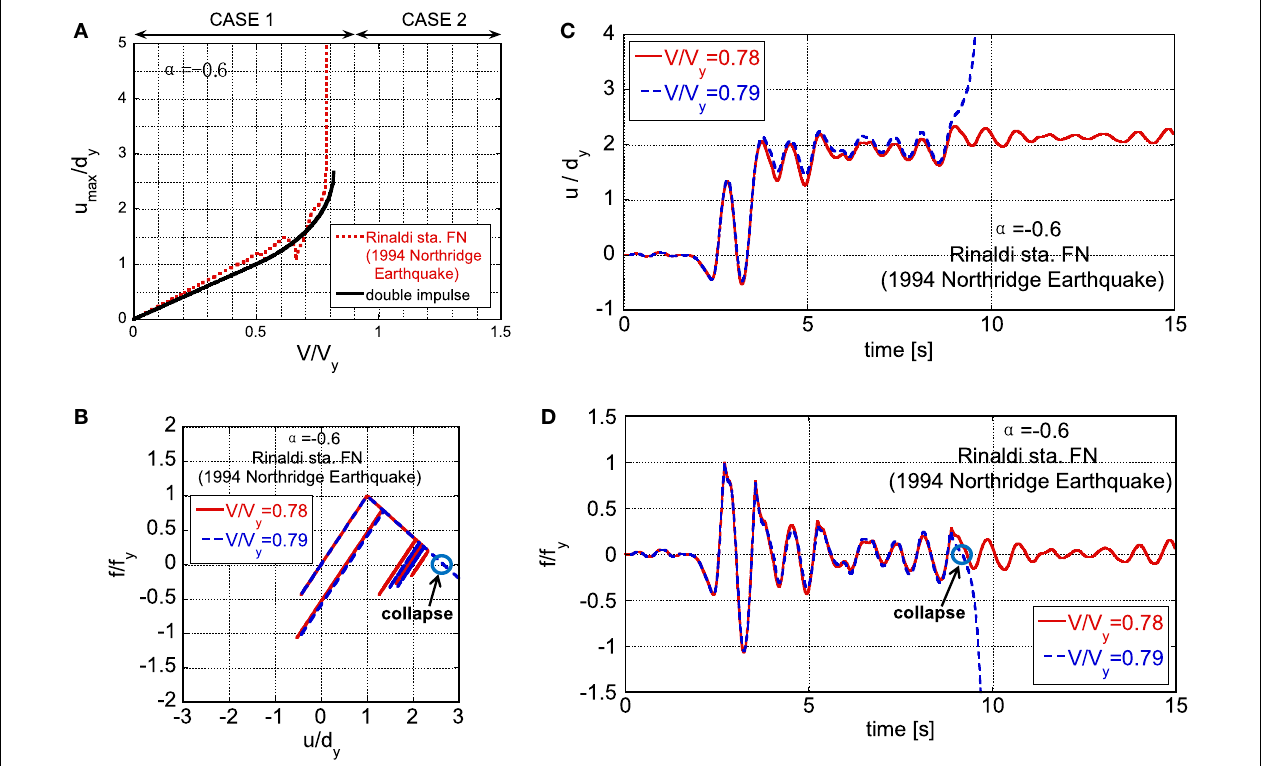
FIGURE 15 | Stable model ( V / V y =0.78) and unstable model ( V / V y =0.79) under Rinaldi station fault-normal component . (A) Maximum deformation with respect to V / V y under Rinaldi station fault-normal component and the corresponding double impulse, (B) restoring force–deformation relation for stable case and unstable case, (C) deformation time–history for stable case and unstable case, and (D) restoring force time–history for stable case and unstable case.